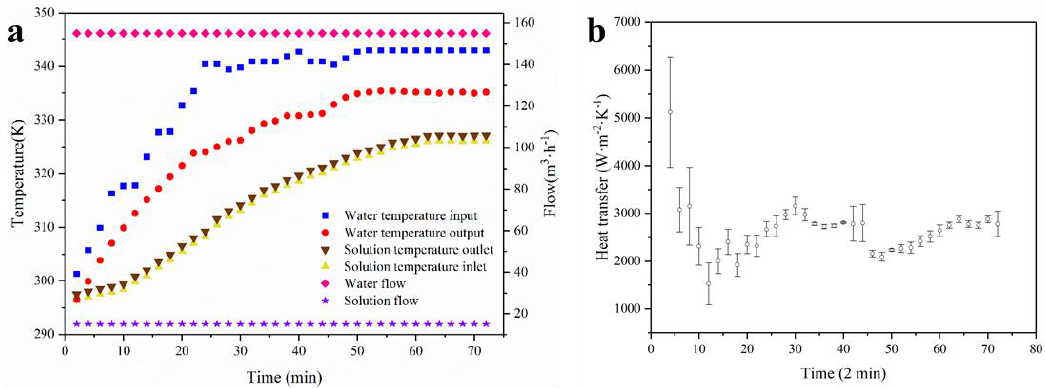
Figure 9. ( a ) Test data of experimental rig; ( b ) Heat transfer of measurable anti-fouling heat